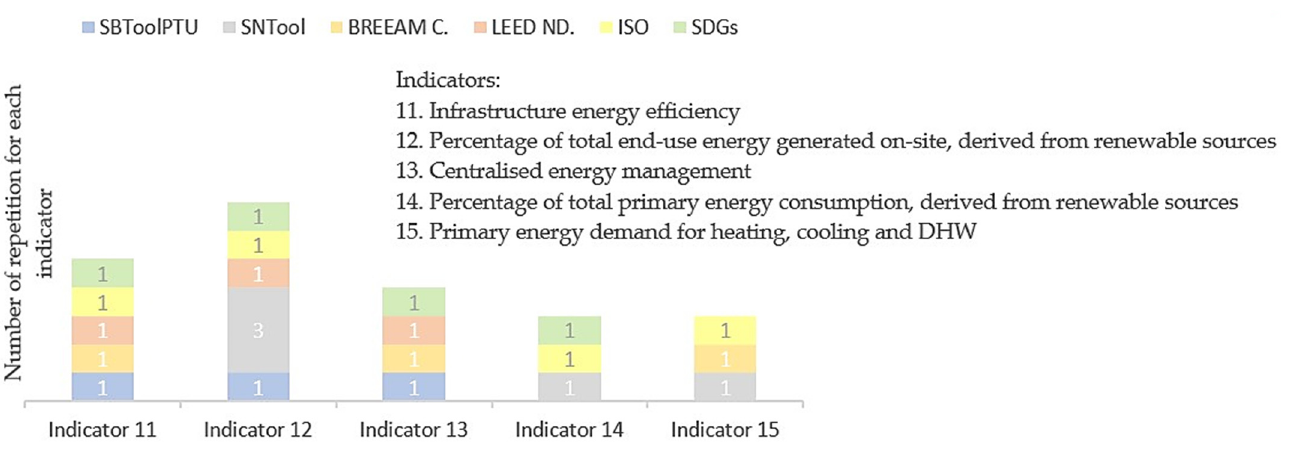
Figure 4. Frequency distribution of each indicator, relevant to the category of energy-saving measures in SBTool PT _Urban (2018), SNTool Min (2020), BREEAM-C (2012), LEED-ND (2018), ISO 37120, and SDGs.